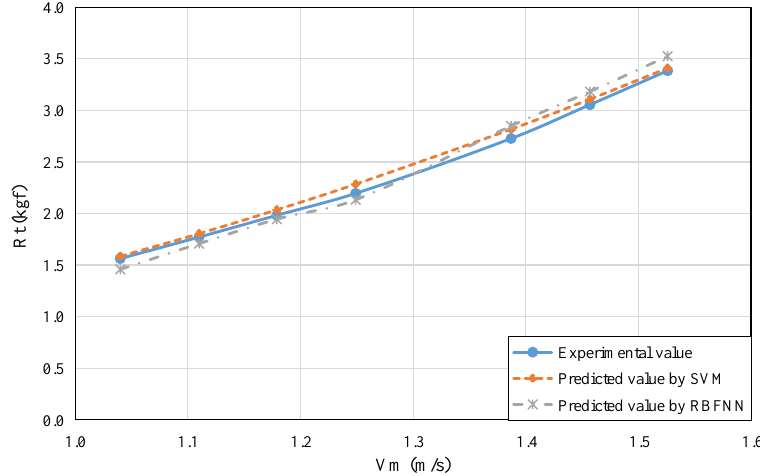
Figure 12. The ship resistance prediction results of the SVM and RBFNN models at the draft = 0.136 m.